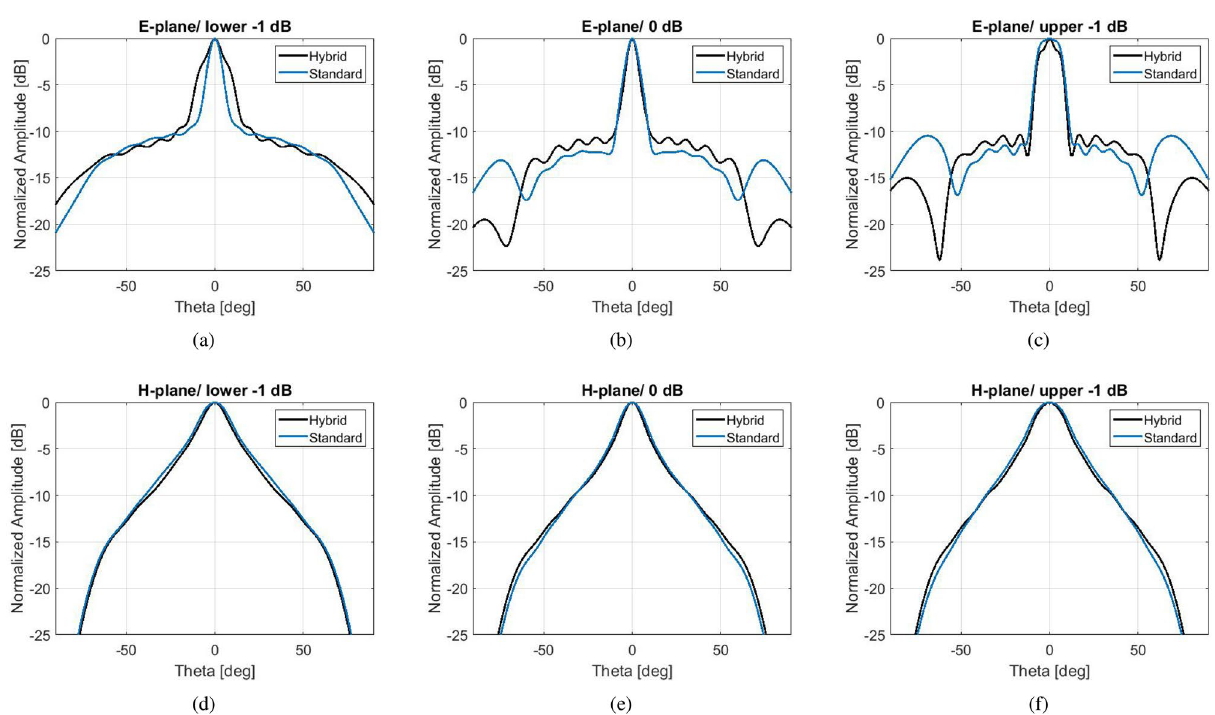
Figure 7. Simulated radiation patterns of the hybrid antenna with flat gain and the standard antenna of the same maximum